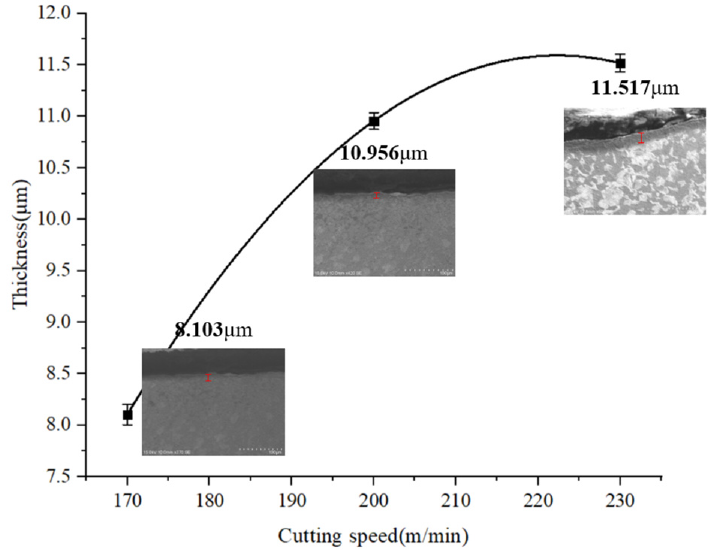
Figure 23. Variation of metamorphic layer thickness with cutting speed.